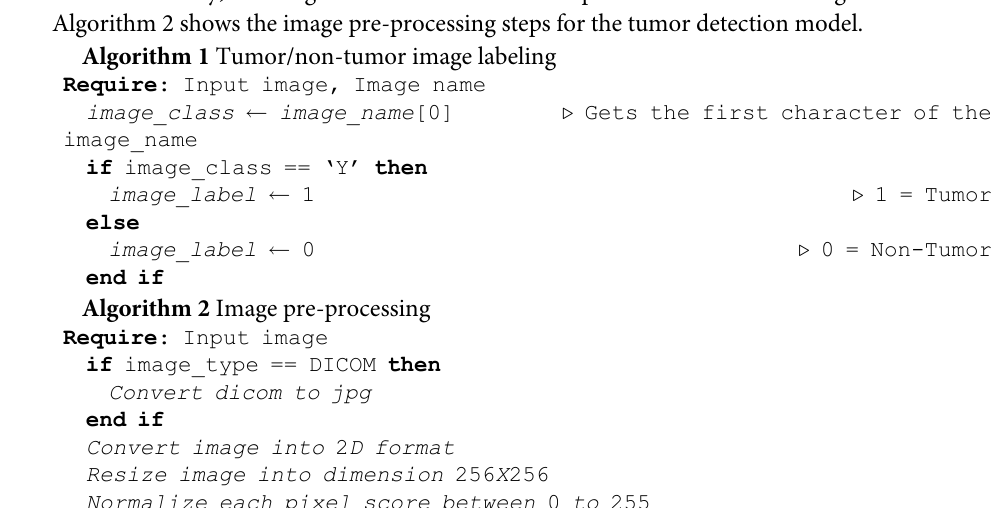
Algorithm 2 Image